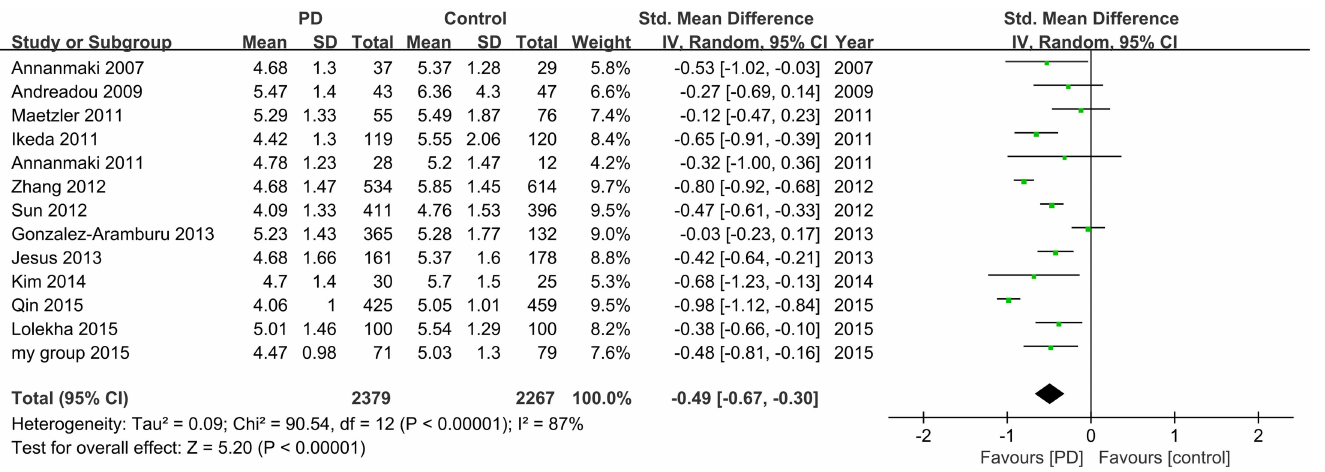
Fig 2. Forest plot of serum uric acid levels in PD compared to